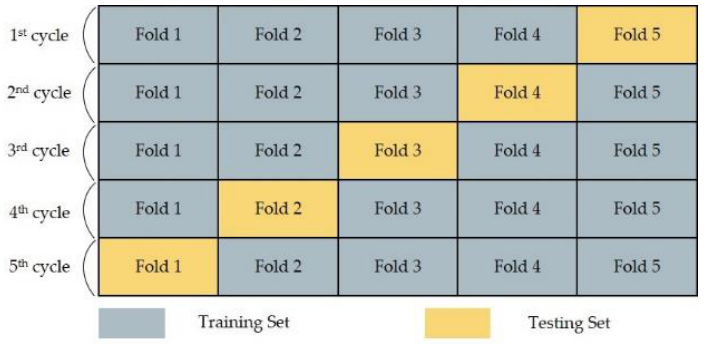
Figure 2. 5-Fold cross validation.